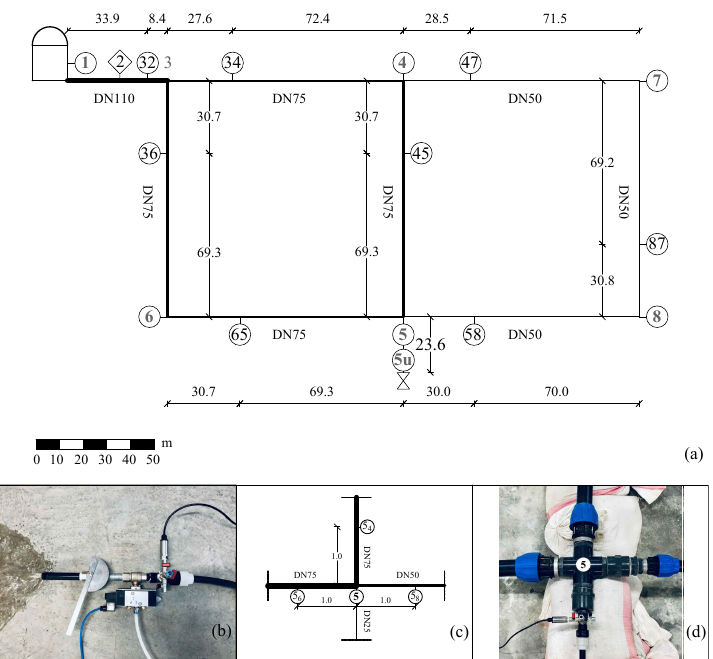
Figure 1. Water Distribution Network (WDN) at the Water Engineering Laboratory of the University of Perugia: ( a ) general layout with the indication of the pipe length and principal measurement sections and the service line installed at node 5 (test #1 configuration); ( b ) end-user 5u; ( c ) location of the measurement sections around junction 5; and ( d ) junction 5 (as an example of the service line connection to the